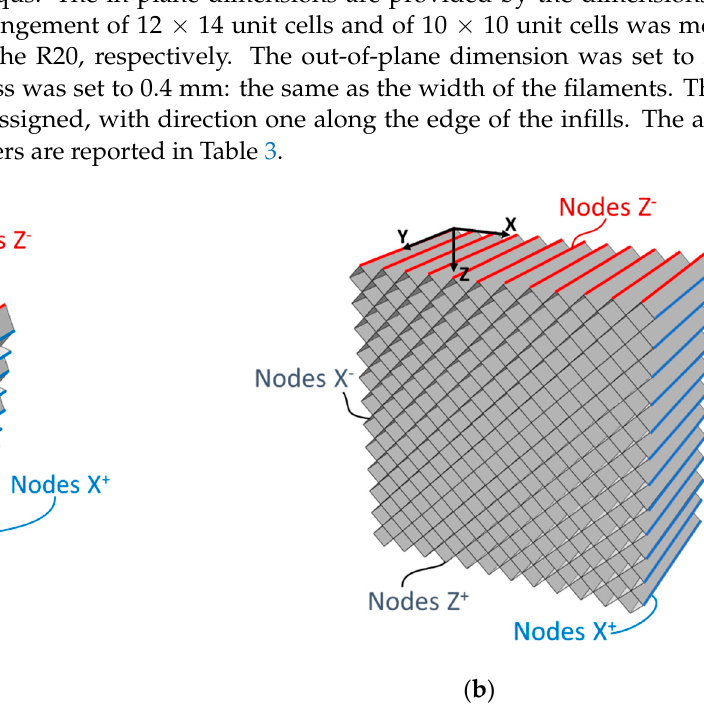
Figure 2. Extracted geometries of the unit-cells for the ( a ) T45 infill and the ( b ) R20 infill. Note that